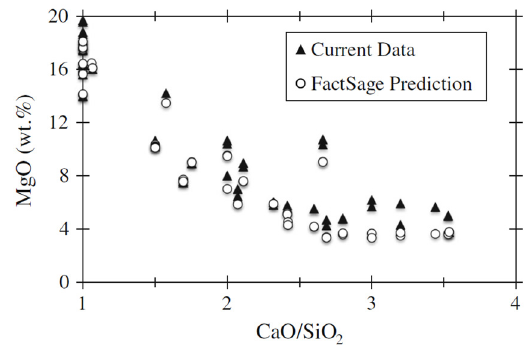
Figure 10: MgO solubility predicted by Factsage, open circles, and the measured solubility based on the chemical analysis results, filled triangles, as a function of the binary basicity at various FeO